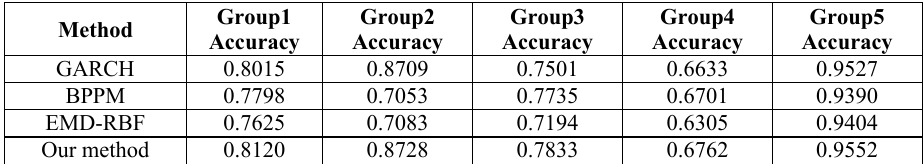
Table 3. Comparison of experimental